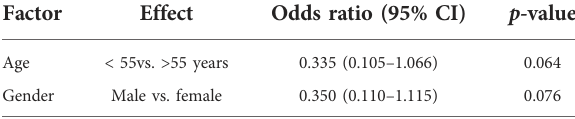
TABLE 4 Binary logistic regression